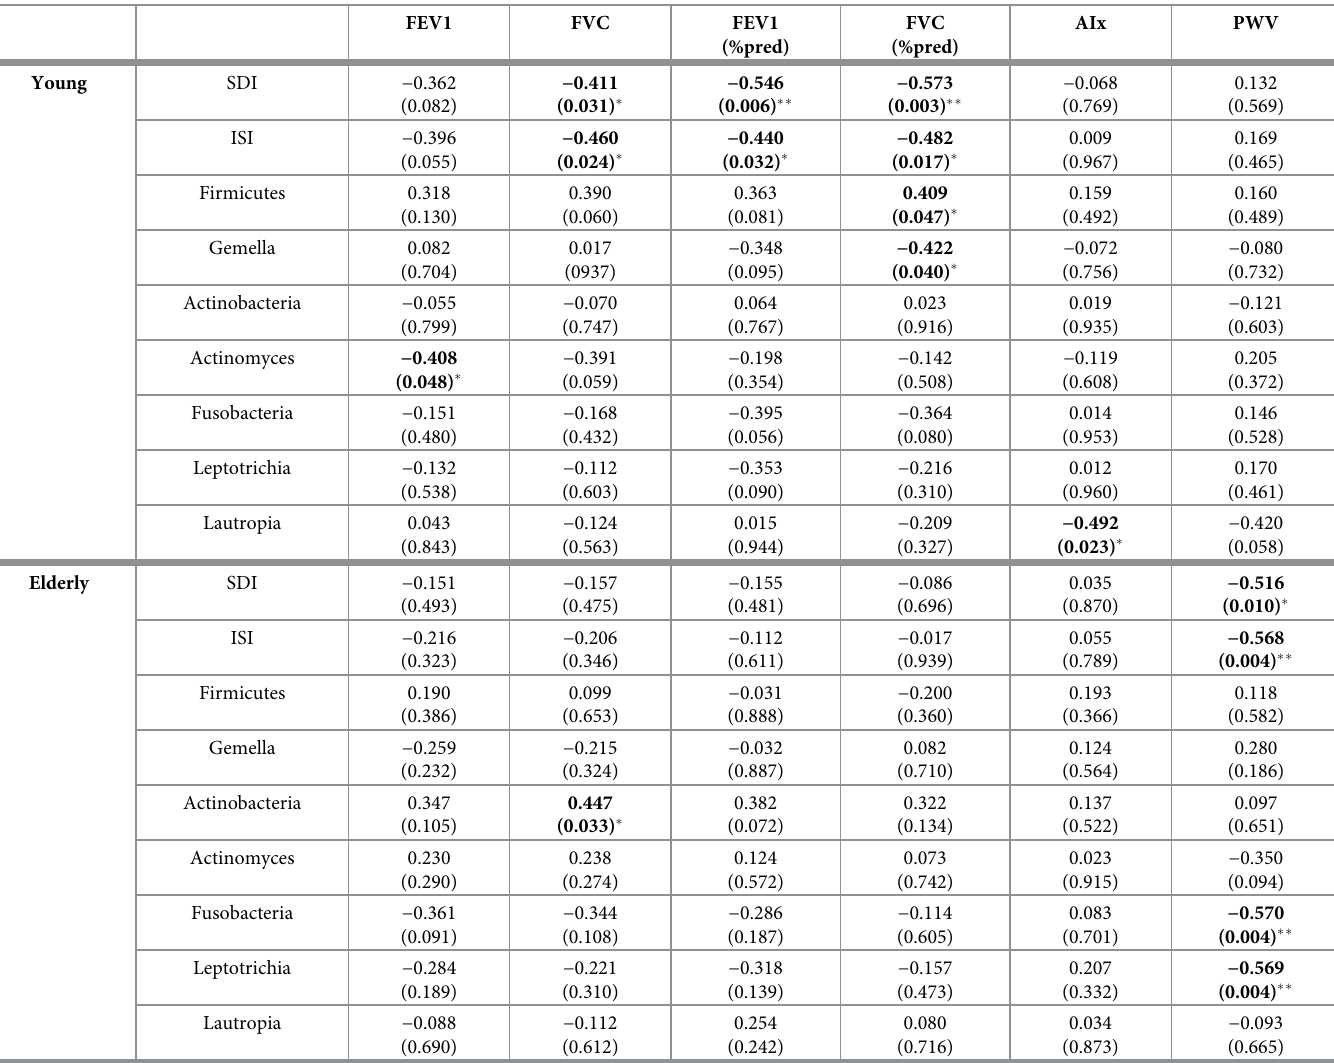
Table 2. Correlation matrix comparing lung microbiome composition with lung function and arterial stiffness parameters among young and elderly subjects. FEV1